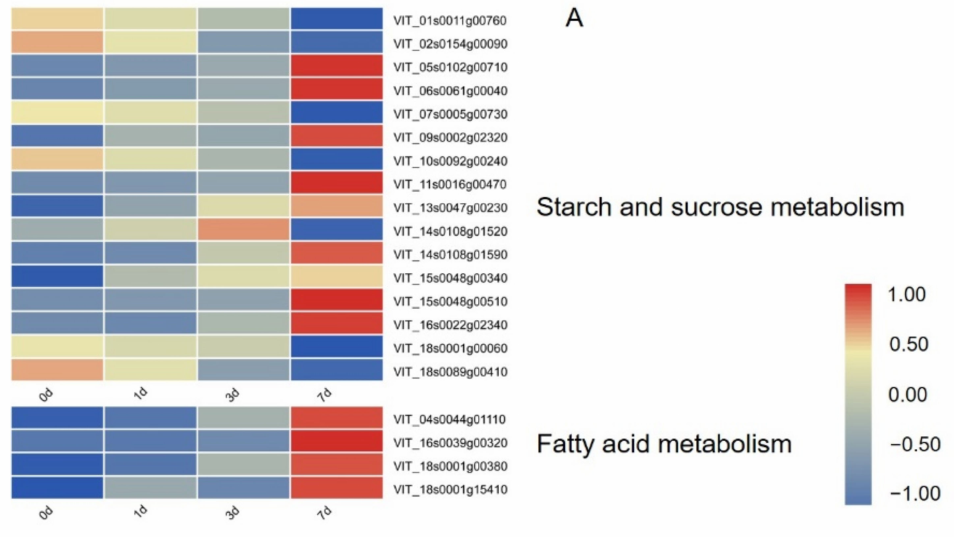
Figure 4. KEGG pathways of differentially expressed genes of Vitis davidi Föex berries infected with Colletotrichum viniferum at 7 dpi.